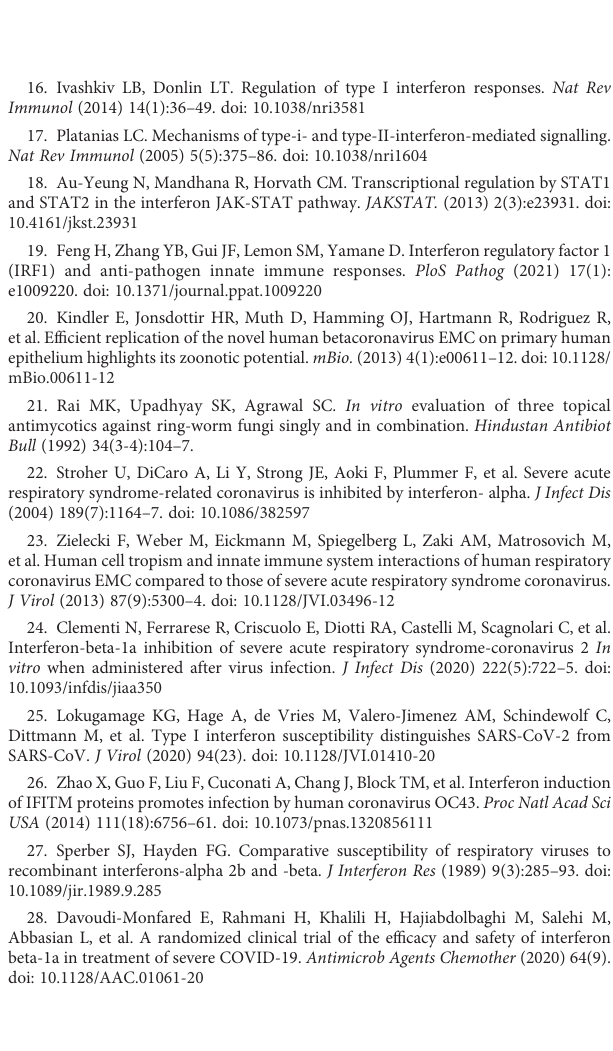
Sequence of qPCR